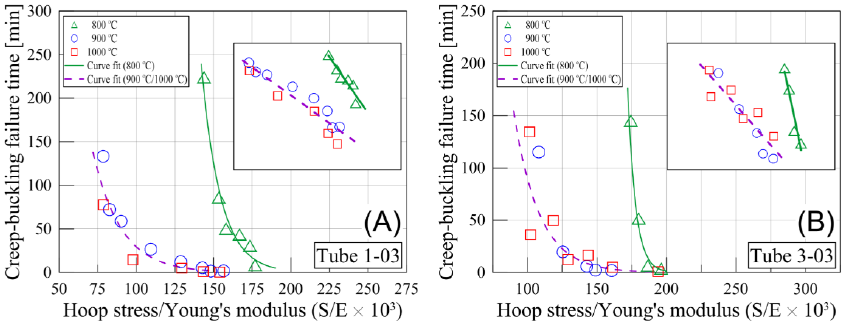
Figure 10. Variation of the creep-buckling failure time with respect to the circumferential stress (hoop